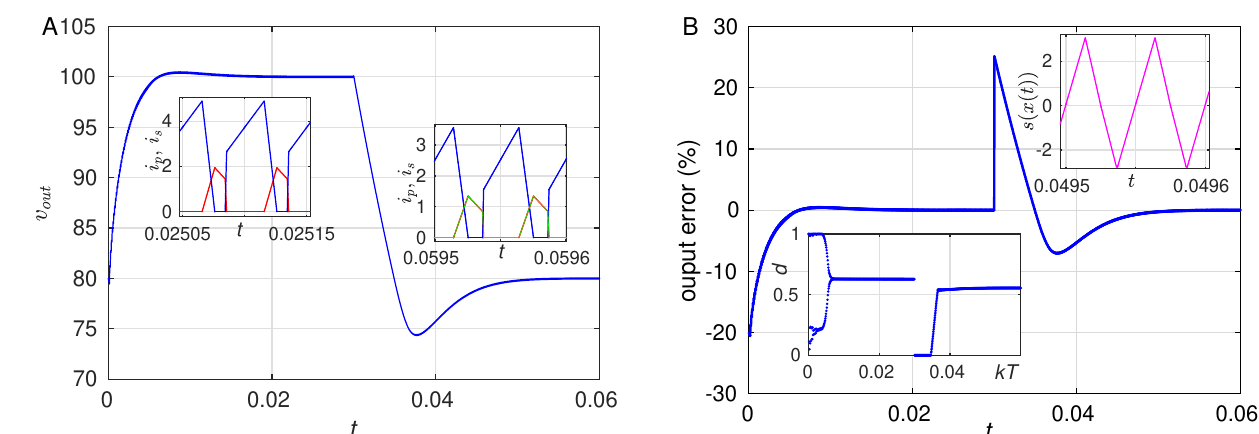
Figure 7. ( A ). Output voltage as a function of time with a disturbance in the reference voltage presented at t = 0.03 s. Insets: primary (secondary) currents are depicted in blue (red) before and after the change in v out . ( B ). Output error as a function of time for the evolution of v out in panel ( A ). Lower inset: dynamics of the duty cycle. Upper inset: function s ( x ( t )) defined in Equation (2). In this figure, the parameters have been chosen, as in Table 2, with a reference variation from v ref = 100 V to v ref = 80 V.